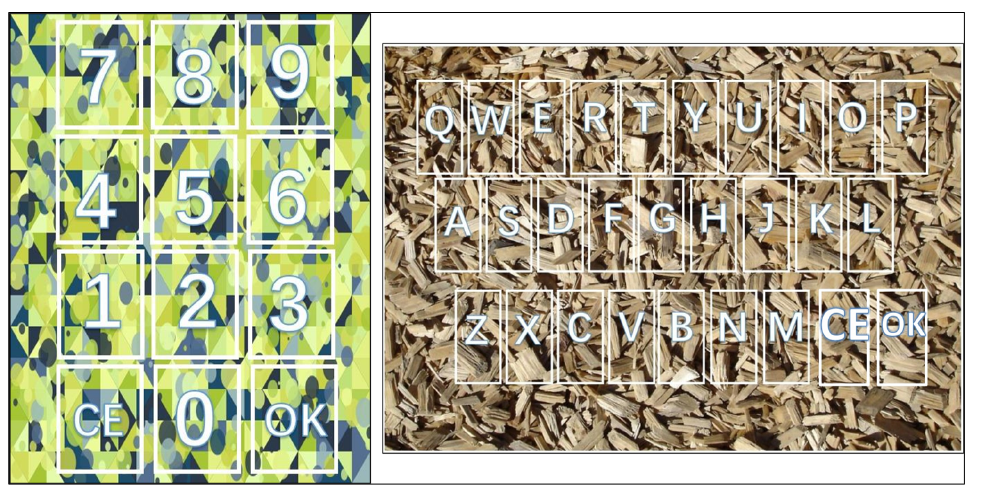
Figure 2. The figure shows two input markers. They can accept the corresponding input parameters through the user clicking on the marker. The content of each block represents the input information when the user clicks on the block. The CE button is used to delete the last number or character, and the OK button is used as a confirmation button. The number virtual marker is generated by a physical constant marker and a number input marker (see Figure 3).